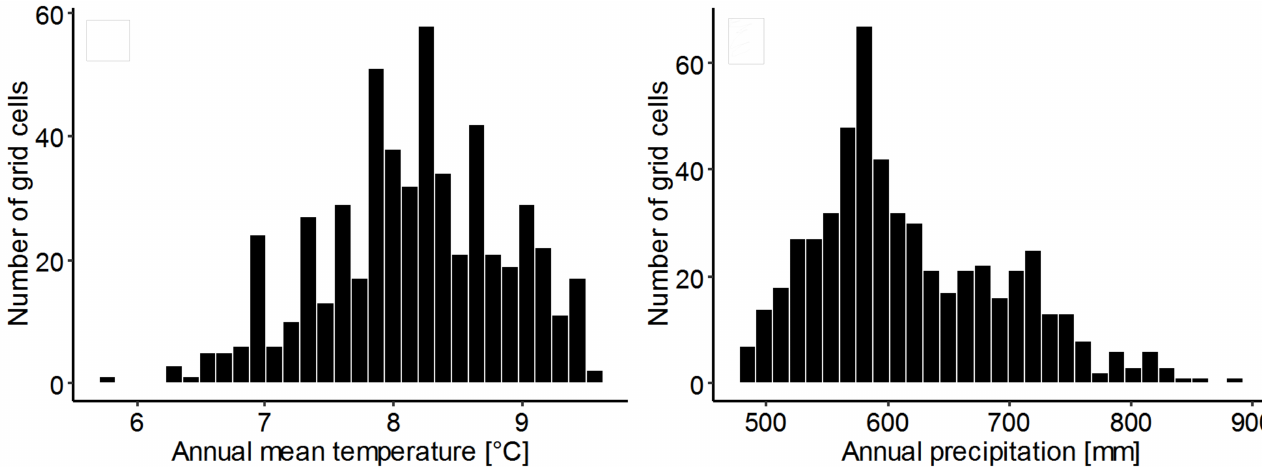
Figure 9. Histograms of the annual mean temperature and annual precipitation of the mapping grid cells in the Czech Republic occupied by Cyperus fuscus .